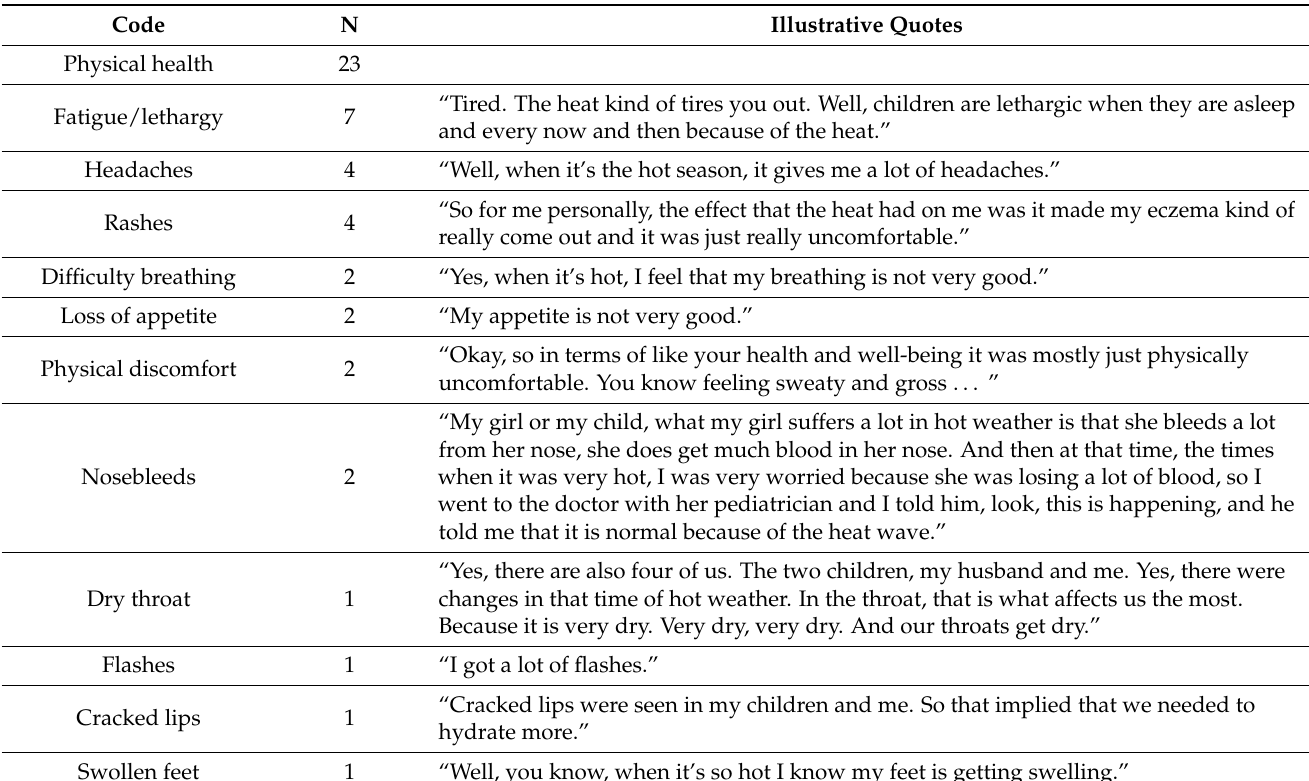
Table 4. Health impacts of heat